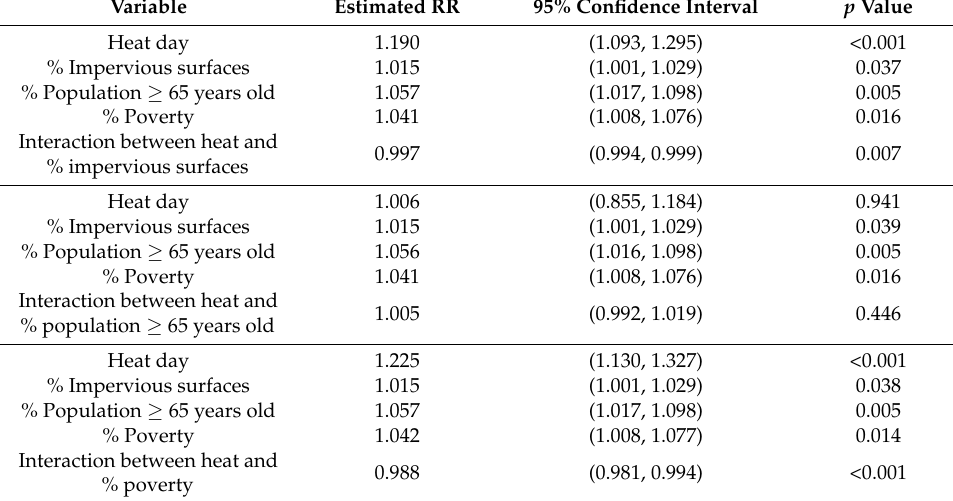
Table 4. Relative rate results: effect modifications of the environmental and demographic factors on the association between heat exposure and daily ALS call counts 1 .